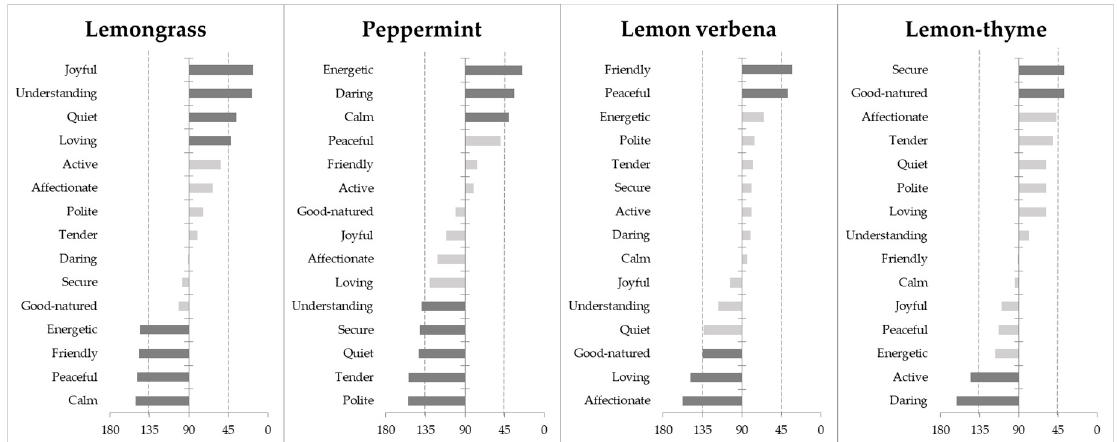
Figure 3. Angles (in degrees) between the vectors from the projections of the four herbal infusions and food-elicited emotion terms in the correspondence analysis map, resulting from multidimensional alignment (MDA) analysis. Dark bars represent the angles below 45°—representing emotion terms positively correlated with the samples, as well as the angles above 135°—representing emotion terms negatively correlated with the samples.